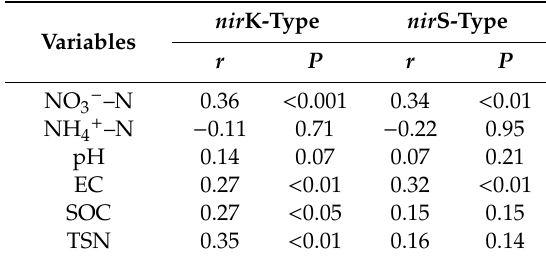
Table 5. Correlations between soil properties and soil denitrifier bacterial communities (Bray–Curtis dissimilarities), as determined by the Mantel